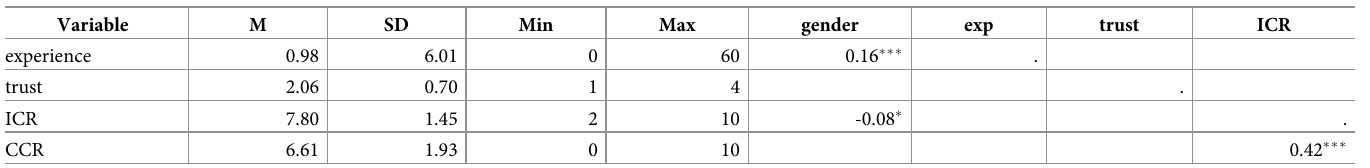
Table 1. Summary statistics and pairwise correlations matrix for the CCR model.